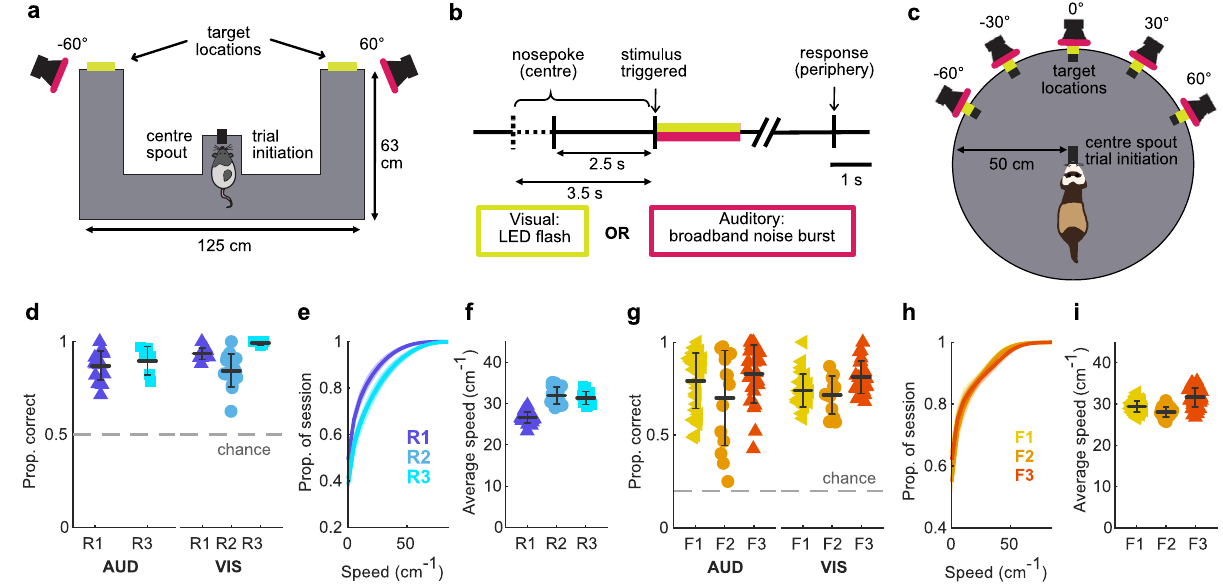
e Cumulative speed distribution across sessions for each rat. The mean and stan- darddeviationofthesessionspeeddistributionsareshownaslineandshadedarea. f Mean session speed of ‘ moving ’ data (de fi ned as speeds >10cms − 1 ) for each rat. Each marker represents one session, shown with the mean and error bars showing standard deviation across sessions. Data are from 3 rats over a total of 55 sessions (see Supplementary Table 1 for sample sizes for individual subjects). g – i as in d – f but for ferret data (chance level: 1/5). Data are from 3 ferrets over 75 sessions (see Supplementary Table 1 for sample sizes for individual